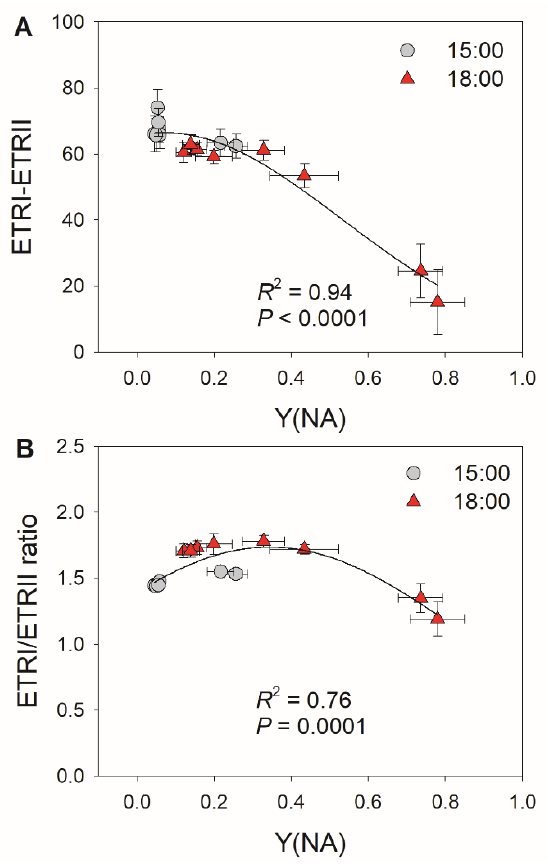
Figure 3. Relationships between ( A ) Y(NA) and ETRI–ETRII and between ( B ) Y(NA) and the ETRI/ERTII ratio during the high light phases under fluctuating light in tomato leaves. Data are shown as mean ± SE ( n = 5).